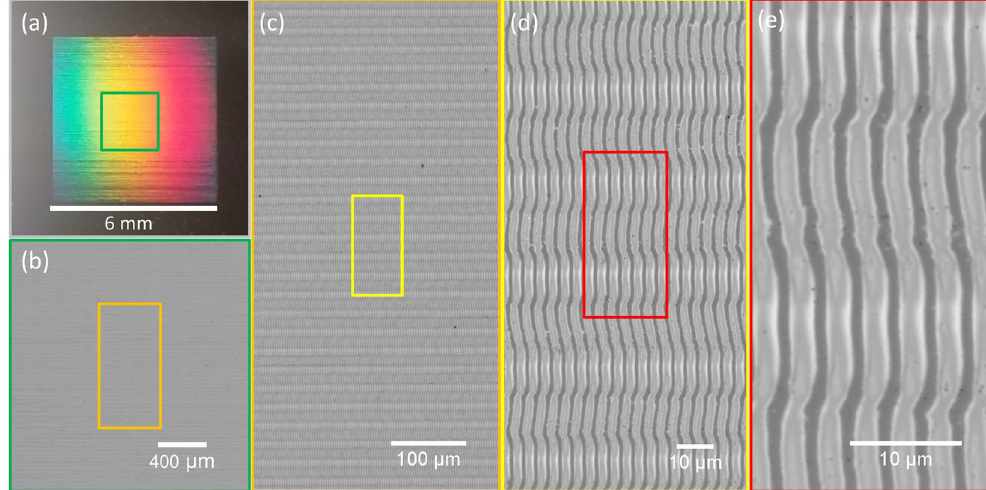
Figure 11. Large area grating (6 × 6 mm) written by scanning the sample in two dimensions. ( a ) Image recorded with a smartphone camera upon angled illumination with white light, illustrating the efficient and homogeneous diffraction. ( b – e ) Optical micrographs recorded with different magnifications M upon illumination with a blue LED at normal incidence. ( b ) M = 2.5 × ( c ) M = 10 × ( d ) M = 50 × ( e ) M = 150 × . The regions over which was zoomed in for each magnification are marked by rectangles. The writing process was performed at a laser repetition rate f = 250 Hz , F = 160 mJ/cm 2 and the sample was scanned continuously at v = 2300 µ m/s along the horizontal direction, with a discrete vertical line separation d = 13 µ m